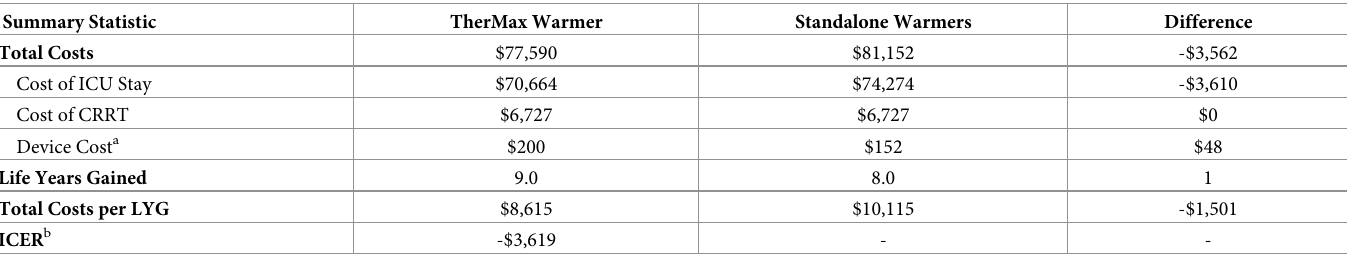
Table 3. Cost-effectiveness